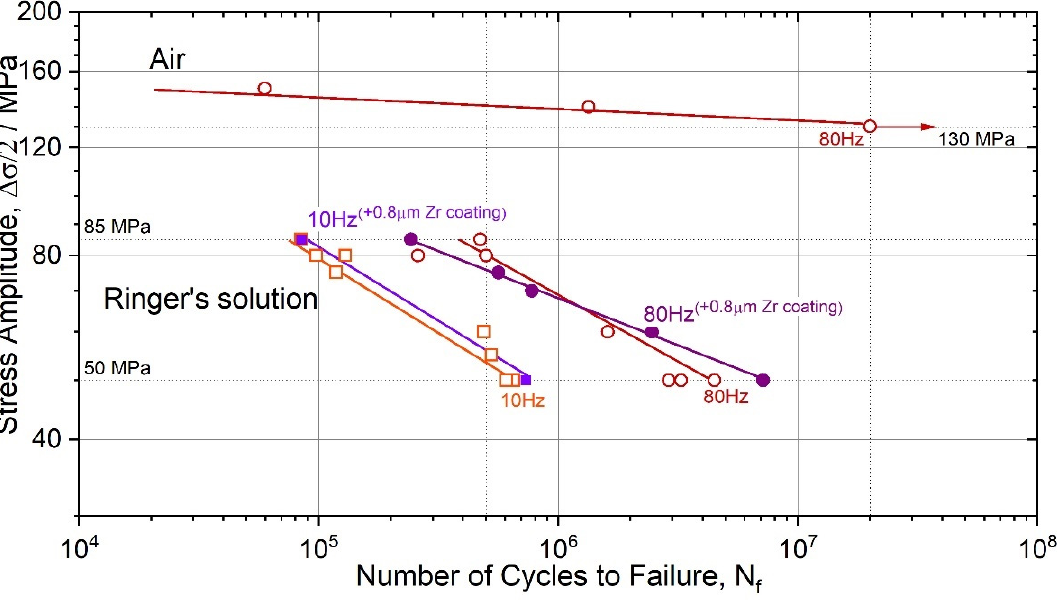
Figure 7. S-N plot for the ZK60 specimens—bare and coated by a 0.8 µ m thick pure Zr coating—tested at 10 and 80 Hz in air and Ringer’s solution.